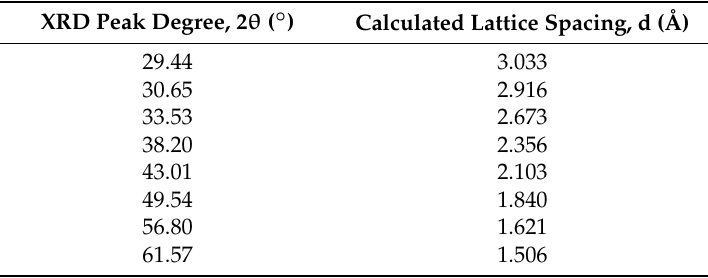
Table 3. (Mg,Al) 2 Ca peak degrees of X-ray diffraction in Rzycho ń ’s work [19] and calculated lattice spacing from these peak degrees.